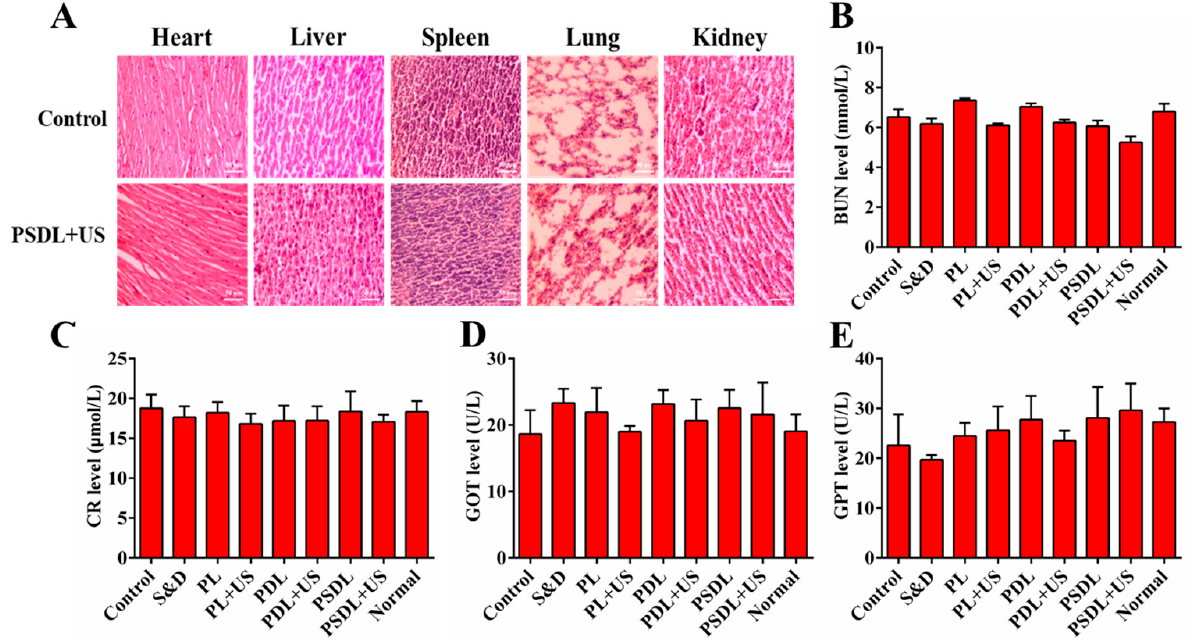
Figure 7. Evaluation of side effects. ( A ) H&E staining of heart, liver, spleen, and kidney tissues